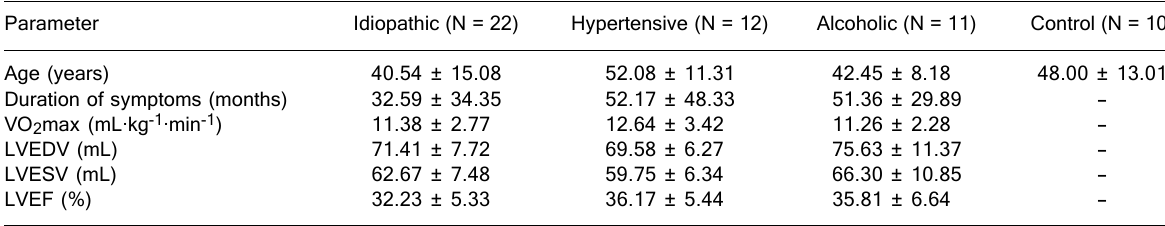
Table 1. Baseline characteristics of the idiopathic, hypertensive, and alcoholic dilated cardiomyopathy and control groups in the present